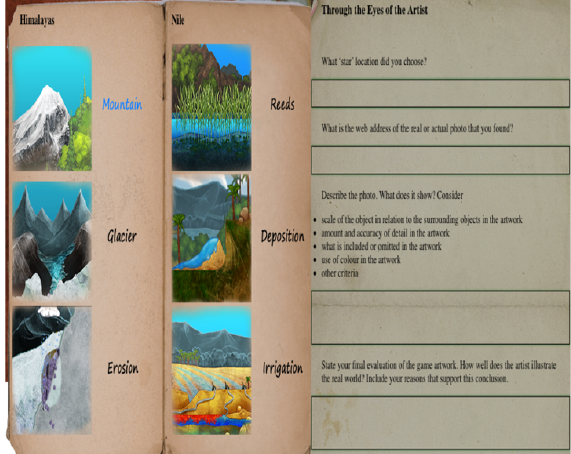
Figure 11. Through the eyes of the artist